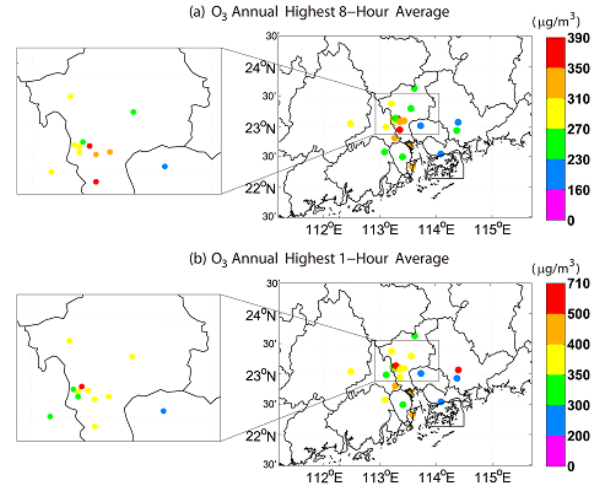
Fig. 2. Ozone concentration (µg m -3 ) of each of the 22 individual sites in PRD region in 2010 of (a) the annual highest daily maximum 8-h average and (b) the annual highest 1-h average.